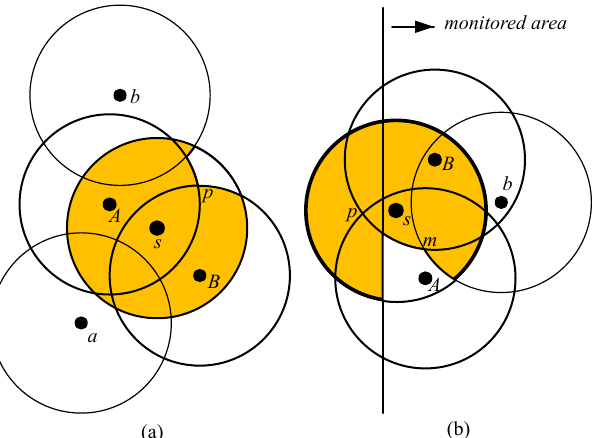
Figure 7. ( a ) The eligibility of s is determined by tracing point p , which is intersected by R NBs , A and B . ( b ) The intersection point of R NBs is out of the monitored area.